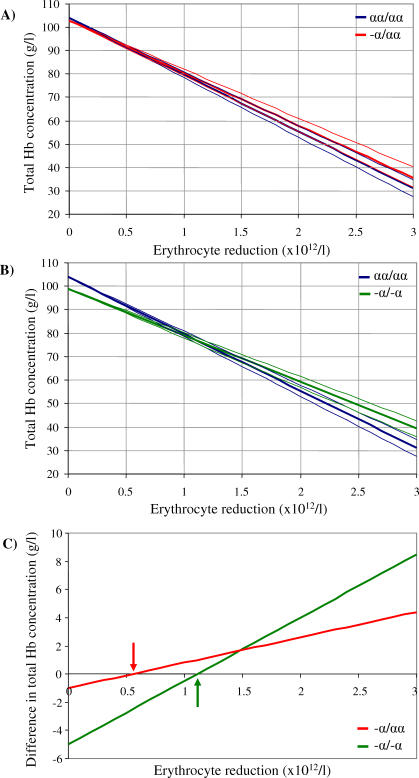
Consequence of Reduction in Erythrocyte Count on Total Haemoglobin Concentration According to α+-Thalassaemia GenotypeThe linear relationship between Hb concentrations and reduction in erythrocyte count can be described by the following linear equation: y
i
= b − m
i
x, where y
i refers to predicted Hb concentration in the ith child, b is the observed Hb value in the community children prior to acute malaria infection taken from Table 1, m
i represents observed MCH in the ith child, and x represents the reduction in erythrocyte count.(A and B) Predicted total Hb concentration of children of normal genotype together with (A) α+-thalassaemia heterozygotes and (B) α+-thalassaemia homozygotes during reductions in erythrocyte count. Thick lines represent median values and thin lines represent the interquartile range. The equations are y = 104 − 24.3x [y =104 − 25.5, y = 104 − 23.1x] for normal individuals; y = 103 − 22.5x [y = 103 − 23.9, y =103 − 21.0x] for heterozygous; and y = 99 − 19.8x [y = 99 − 18.8x, y = 99 − 21.1x] for children homozygous for α+-thalassaemia.(C) Difference in total predicted Hb (y) between those of normal genotype and heterozygous children (y = 1.8x − 1, red line, data from [A]), and between those of normal genotype and homozygous children (y = 4.5x − 5, green line, data from [B]). The crossover point where heterozygous individuals have a greater Hb concentration relative to those of normal genotype is an erythrocyte reduction of 0.56 x1012/l (red arrow). The crossover point where homozygous individuals have a greater Hb concentration relative to those of normal genotype is an erythrocyte reduction of 1.1 x1012/l (green arrow). These crossovers are also seen in (A) and (B) but are better visualised here.